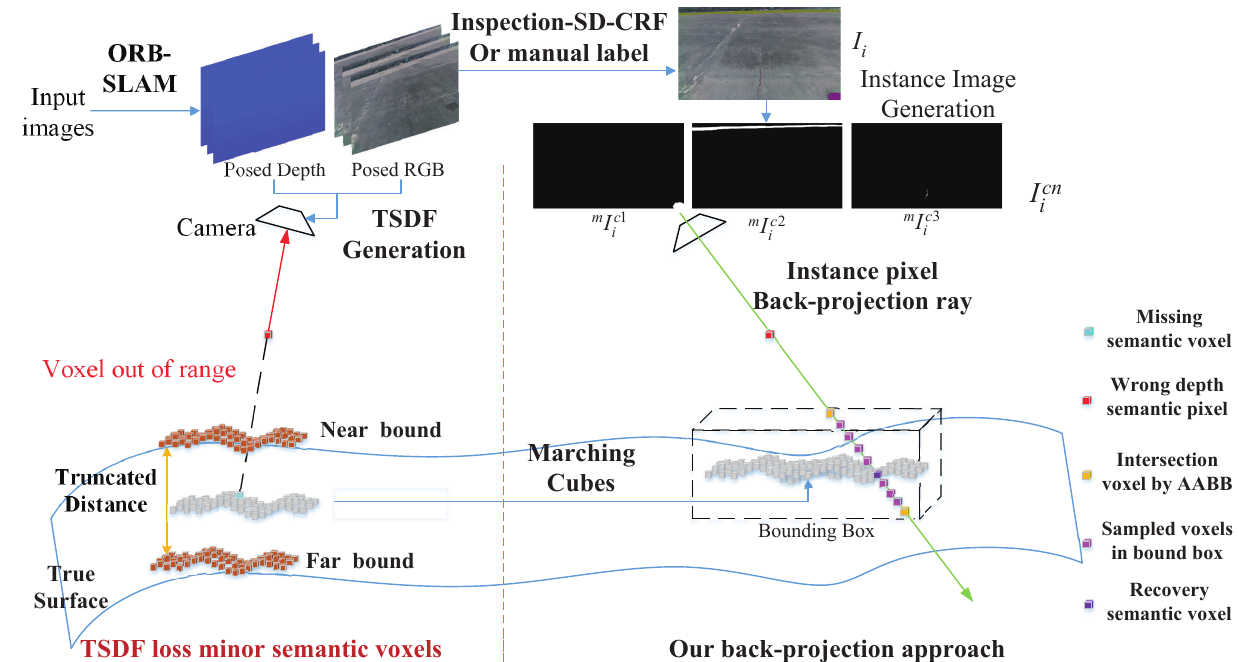
Figure 6. Keyframes back-projection method. The left side shows why the original TSDF method loses semantic voxels during the sparse keyframe reconstruction process. Due to the limitation of the truncated value, the sparse defect semantics will be removed as outliers during the fusion process. On the right, the semantic pixels are restored to the initialized 3D grid using the keyframe instance image pixel back-projection